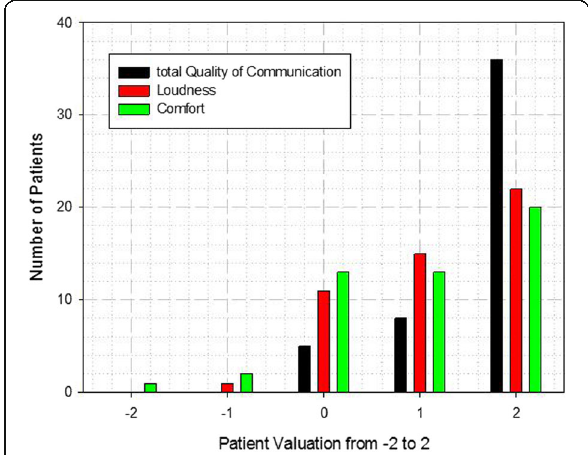
Fig. 5 Result of the patient questionnaire ( − 2, very bad; 0, neutral; + 2,